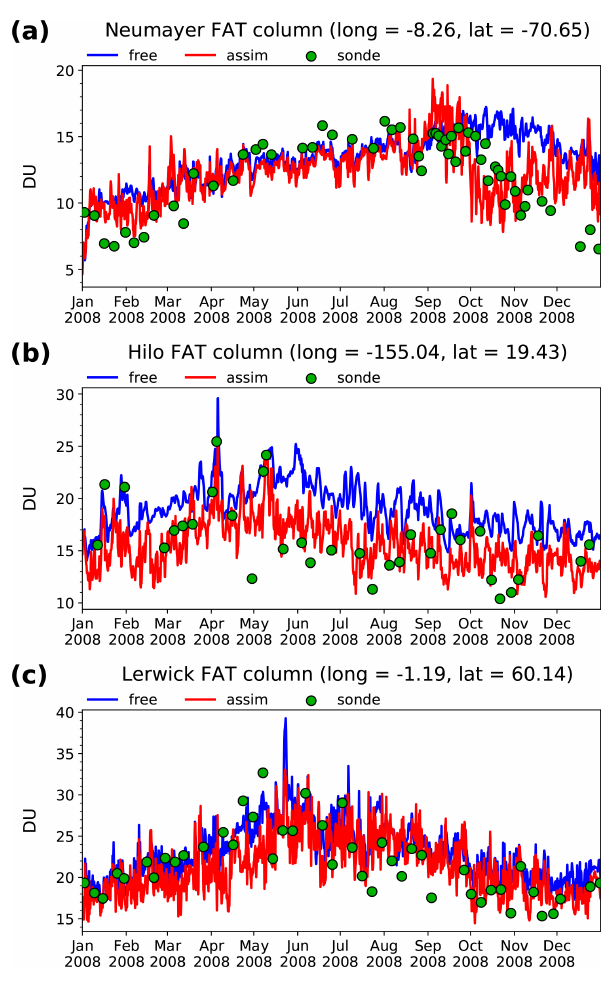
Figure 8. Three time series of collocated model output and ozone sonde measurements. From top to bottom: Neumayer (a) , Hilo (b) and Lerwick (c) . The station coordinates are indicated in the plot titles. Blue line: FAT column from model run without assimilation; red line: FAT column from model run with assimilation of GOME-2 and OMI measurements; green circles: ozone sonde